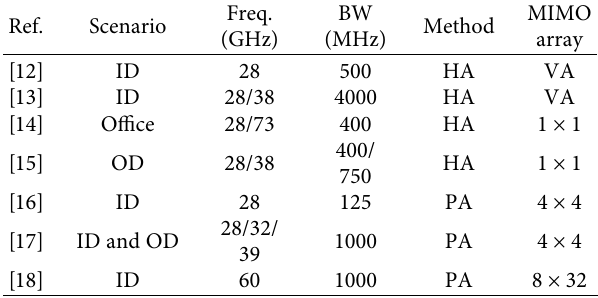
Table 1: Related mmWave channel measurements. Ref.